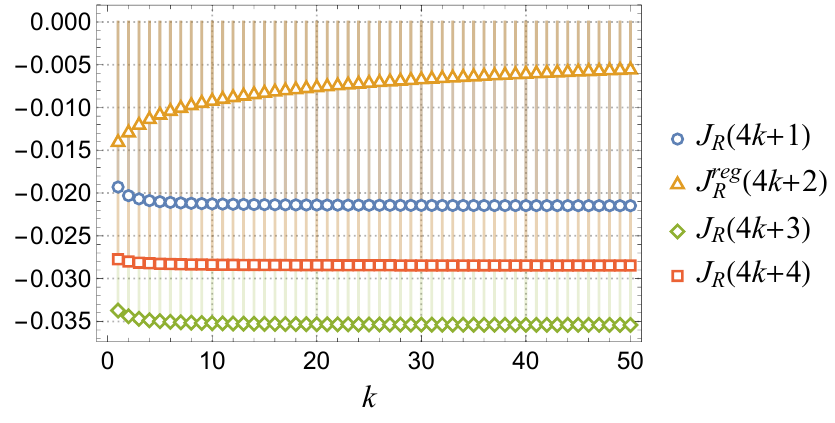
Figure 2 . J R ( n ) (and its regularization) for charged Ramond